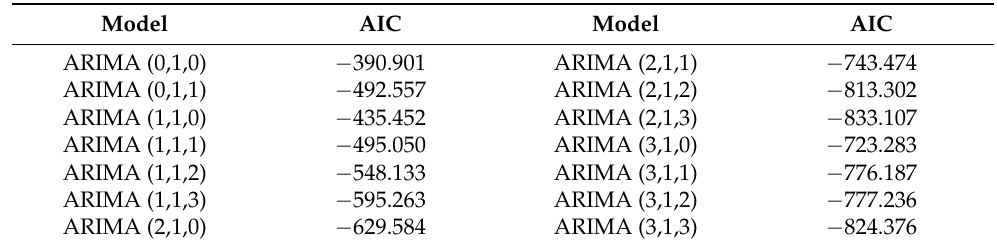
Table 6. Comparison of the ARIMA models. ARIMA (2,1,3) was selected as the best model with the lowest